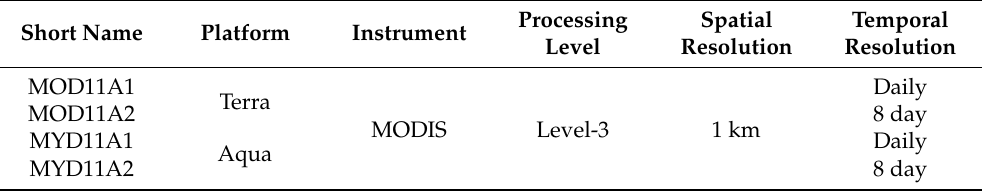
Table 2. Satellite products information.